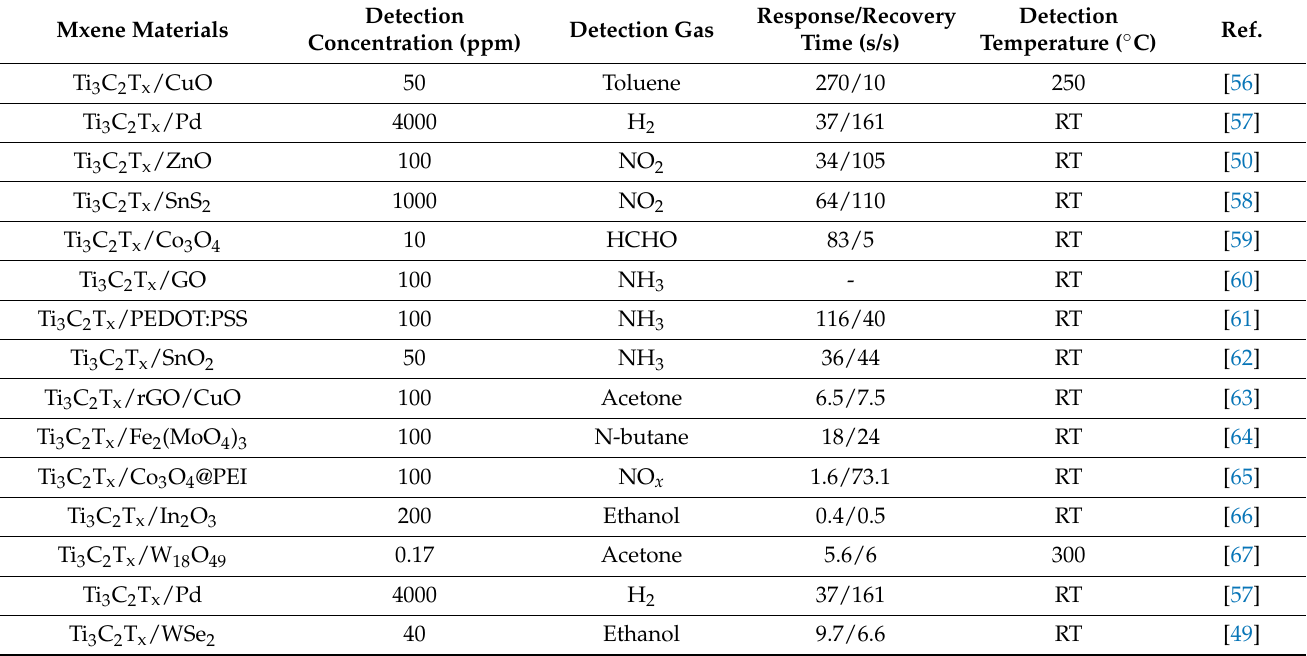
Table 2. Modification of MXene materials for gas sensing